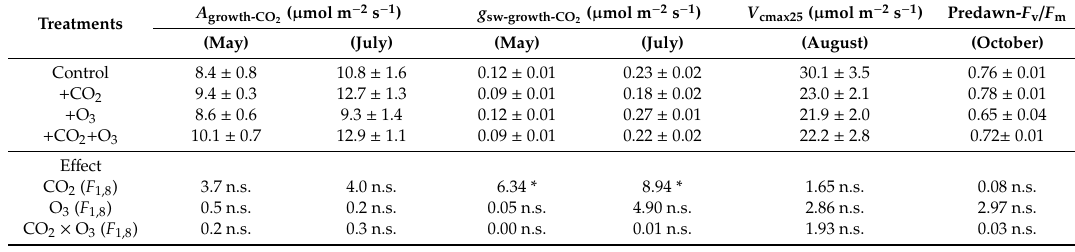
Table 1. Light-saturated net CO 2 assimilation rate ( A growth-CO ) and stomatal conductance 2 ( g sw-growth-CO ) in May and July at each ambient CO 2 level (380 and 550 µ mol mol − 1 ), the maximum 2 rate of carboxylation at 25 ◦ C ( V cmax25 ) in August, and the maximum PS II photochemical e ffi ciency ( F v / F m ) at predawn in October in the first flush leaves of F. crenata grown under ambient air (control), elevated CO 2 ( + CO 2 ), elevated O 3 ( + O 3 ), and the combination of elevated CO 2 and O 3 ( + CO 2 + O 3 ). Values at upper half lines are means ± SE of three replicates for each treatment. F values of analysis of variance (ANOVA) to test the main e ff ects of CO 2 , O 3 , and their interactions are also shown at lower half lines. Significant e ff ects are indicated by *; p < 0.05, and n.s.; non-significant. Treatments